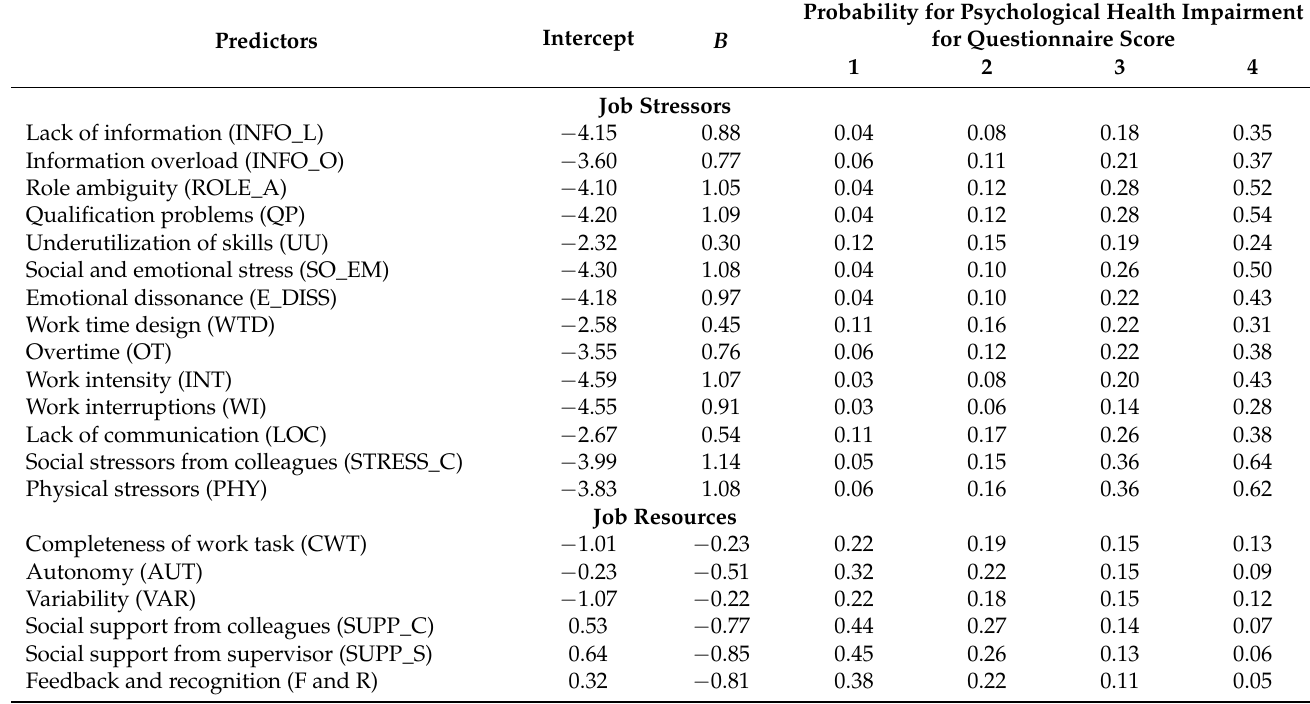
Table 3. Prediction of psychological health impairment based on single job stressor and resources scores. Probability for Psychological Health Impairment for Questionnaire Score Predictors Intercept B Job